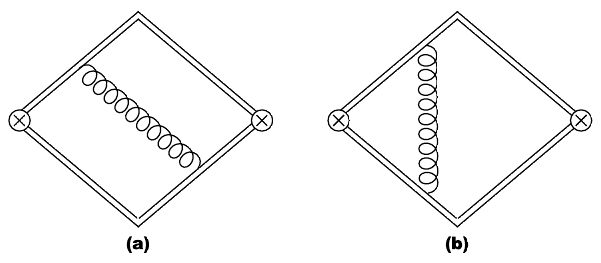
Figure 3 . Diagrams contributing to the one-loop soft function.